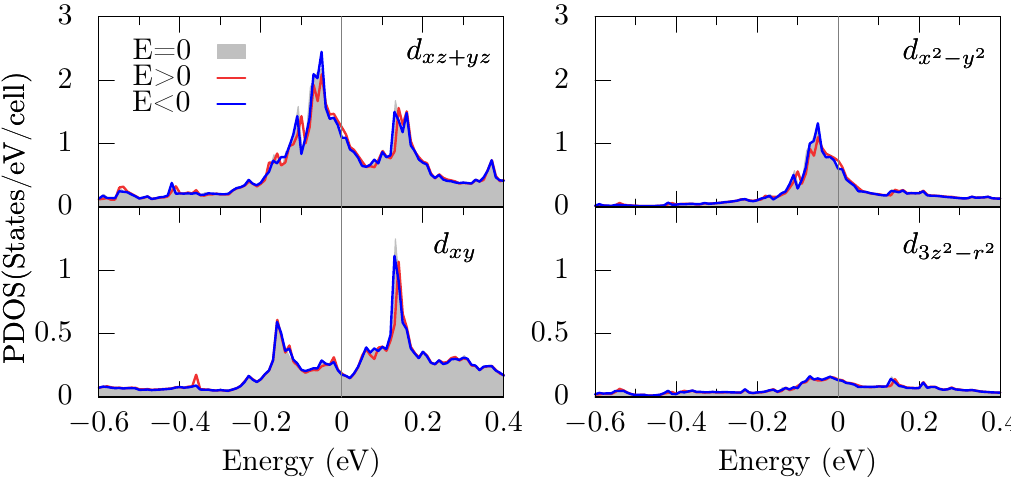
Figure 12. Projected density of states (PDOS) of minority-spin states Fe 1 for η Fe = the EFs of E = 0 (shaded area), E = +0.507 V/nm (solid red line), and E = (solid blue line),